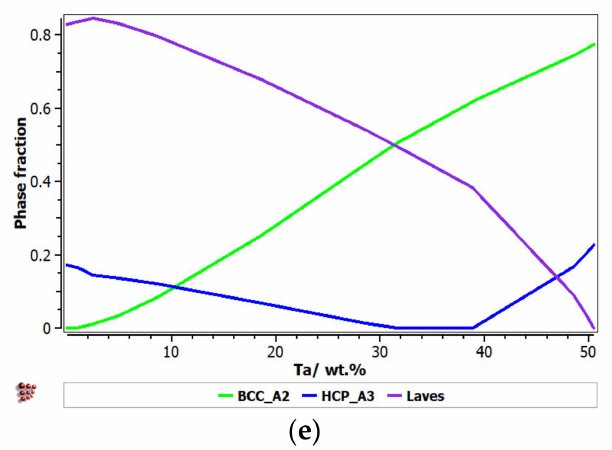
Figure 1. The proportions of phases that can be found in the FeTaNbTiZr alloy system at 200 ◦ C, depending on the variation of ( a ) Zr; ( b ) Nb; ( c ) Ti; ( d ) Fe; ( e )